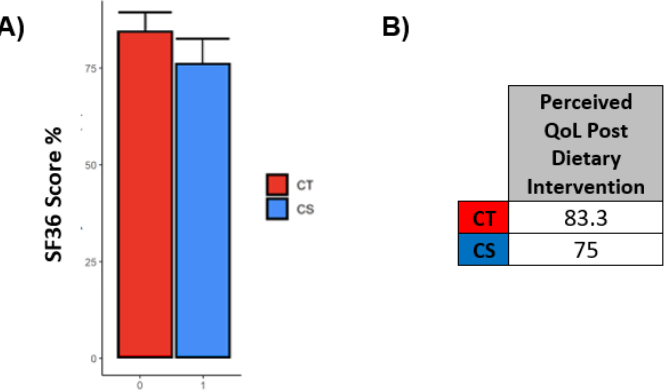
Figure 3. ( A ) — Perceived Quality of life scores after dietary intervention evaluated through SF36 questionnaire; ( B ) — Numerical values for the graphs shown in Figure 3A. tionnaire; ( B )—Numerical values for the graphs shown in Figure